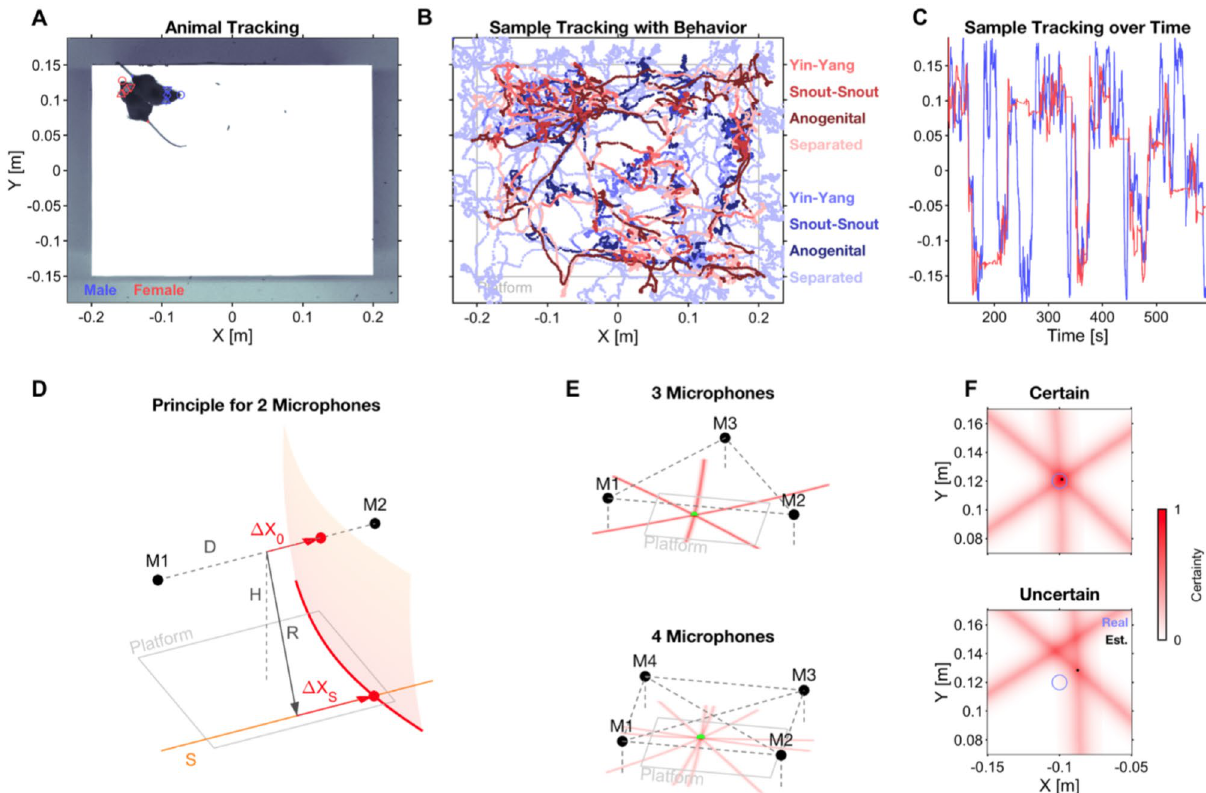
Figure 2. Localizing and attributing USVs to interaction partners in 2D. The assignment of USVs to a mouse requires (i, top row) visually tracking both mice and (ii, bottom row) localizing the origin of the USV in space, followed by assignment to the closest mouse (see Methods for detailed criteria). ( A ) Individual mice were tracked continuously at multiple body parts using DeepLabCut 23 , Male: blue, Female: red; Snout: circle, Left ear: downward triangle, Right ear: upward triangle, Head center: rhombus, Tail onset: dot. Female mice were shaved on the top of their head to allow automatic recognition in DLC. Black spots on the platform are feces from the current trial (cleaned with ethanol wipe between trials). ( B ) Sample trace from a single recording, including multiple automatically scored behaviors (JAABA, see Kabra et al . 24 ; indicated by thickness/brightness of the trace, see legend, color indicates sex). ( C ) Sample traces of snout markers of both animals over time after DLC tracking and post-hoc filtering, demonstrating smooth traces without switching. ( D ) Spatial localization of the origin of each USV was performed using multiple, partial localizations from pairs of microphones (M1/2), including correction for elevation. A cross-correlation measure (EWGCC; see Heckman et al . 17 ) indicated a set of possible origins between the microphones which lies on a 2D manifold (translucent red, right). Correcting for the height H of the microphones above the platform, a curve of possible origin curves (red, platform level) results for each single microphone pair (see Methods for details). ( E ) Complete localization in 2D can be performed using 3 or more microphones. The origin curves (light red) from each pair of microphones ideally intersect in a single point, indicating the unique origin of the USV (black dot). For 3 microphones (top, M1-3), there are 3 curves that can intersect. For 4 microphones (bottom, M1-4), there are 6 curves, which increases the accuracy and robustness against noise. ( F ) The certainty of localizing USV origin can be assessed on the level of single USVs. If the origin curves intersect in precisely one point, the certainty of the estimate is high, whereas the quality of the estimate is worse if various intersections of the curves are more spread